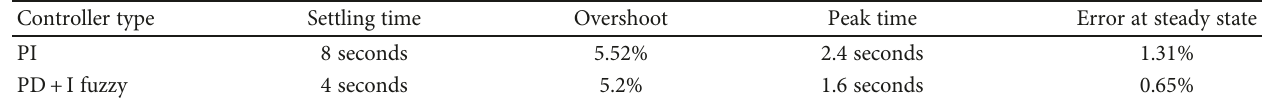
Table 3: Response parameters of the DC bus